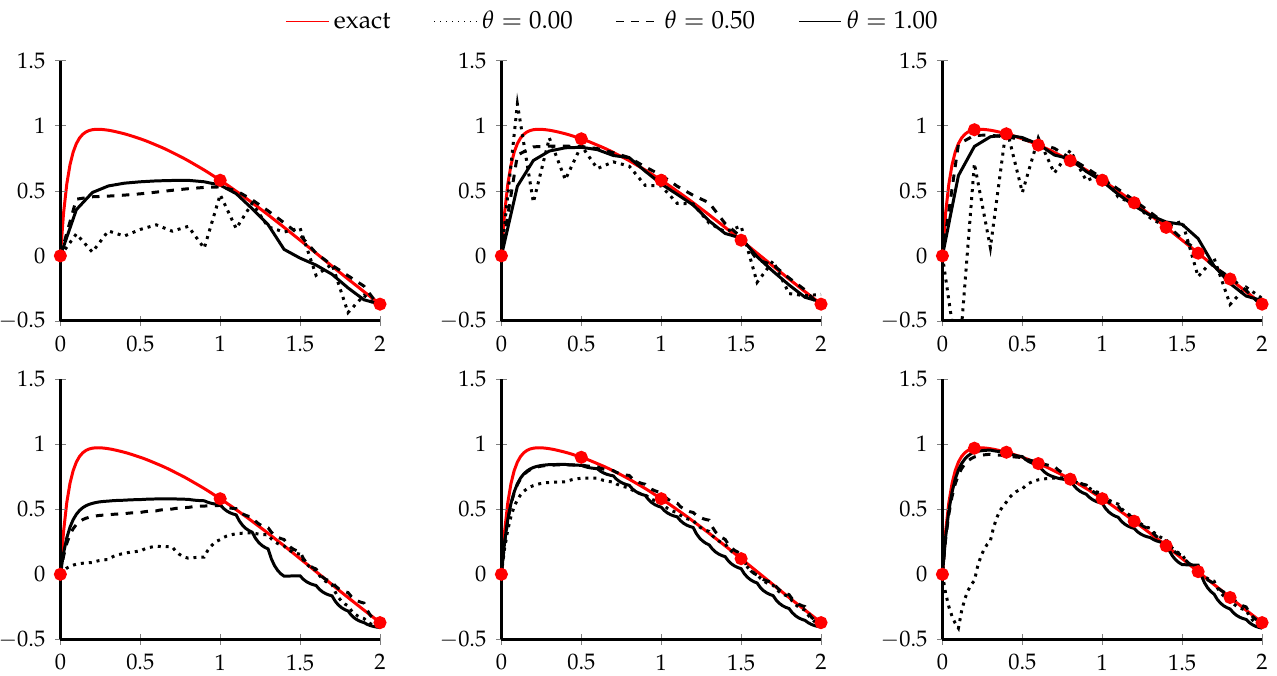
Figure 9. (Top) A single trajectory generated by three trained implicit residual networks for the problem in Example 2. (Bottom) Continuous-time trajectory generated by the learned vector fields of these residual